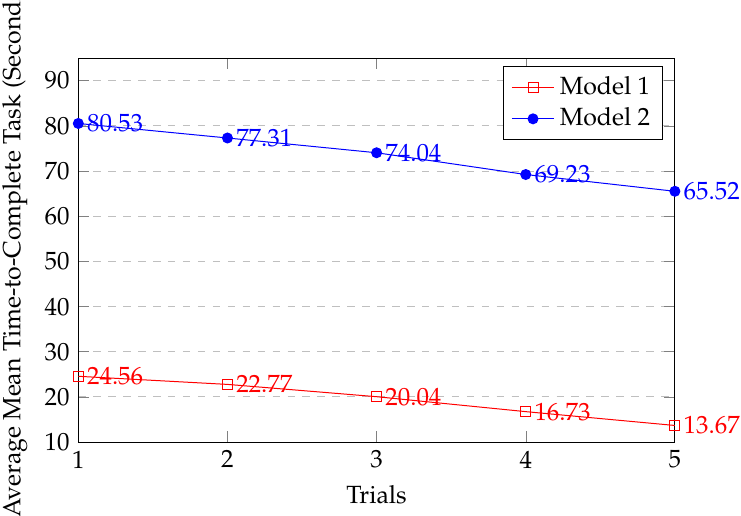
Figure 16. Average mean time-to-complete the tasks for each model and trial by participants.